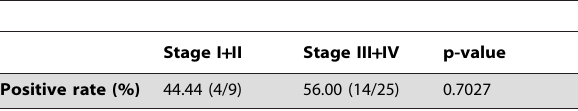
Table 6. Comparison of the rate of chronic endometritis between early stages (I + II) and late stages (III + IV).